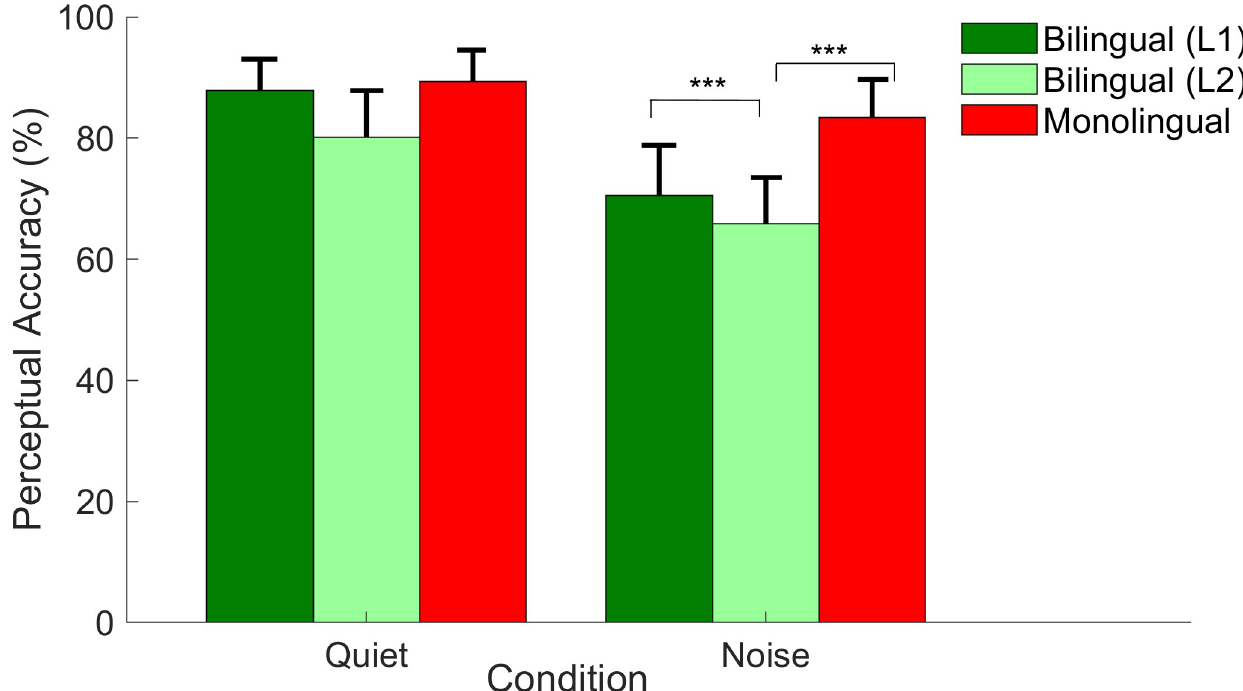
Fig 2. Perceptual accuracy among the bilingual group in L1 (Arabic; dark green columns), L2 (Hebrew; light green columns), and the monolingual group (Hebrew; red columns) in quiet and noise. Error bars represent the standard deviations of the mean. Asterisks denote significant differences between groups or languages. ��� p <